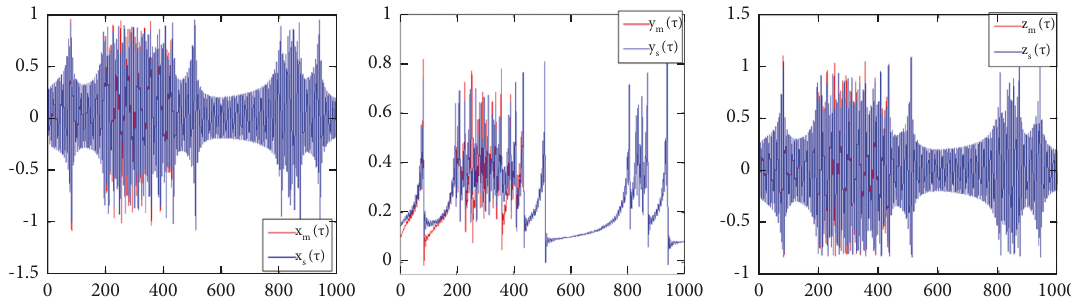
Figure 9: Time series of the state variables of outer 1 and outer 2 for c 0 , 0 . 15 , 0 . 25 , and 0 . 3 , 0 . 2 , 0 . 4 , respectively, for the outer 1, outer 2, and relay ( ) ( ) A cover image and text file secret image are used in Figure 10. The text file secret message is firstly encrypted by using an affine cipher based on adaptive synchronization between the relay coupled three three-dimensional autono- mous systems with a parabolic equilibrium with the support of the date of birth (DOB) keys. The DOB keys enable to construct a key by using birth day, month, and year of the sender (S) and receiver (R), respectively. Then, the least